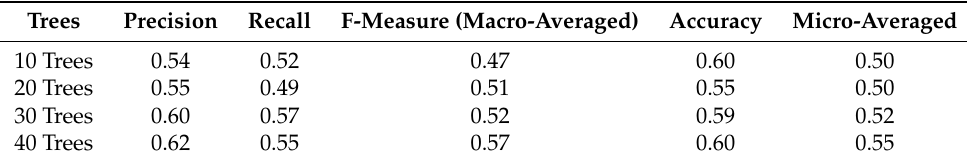
Table 7. Results of Random Forest showing Accuracy, Precision, Recall, F-measure against different parameters of the algorithm obtained using